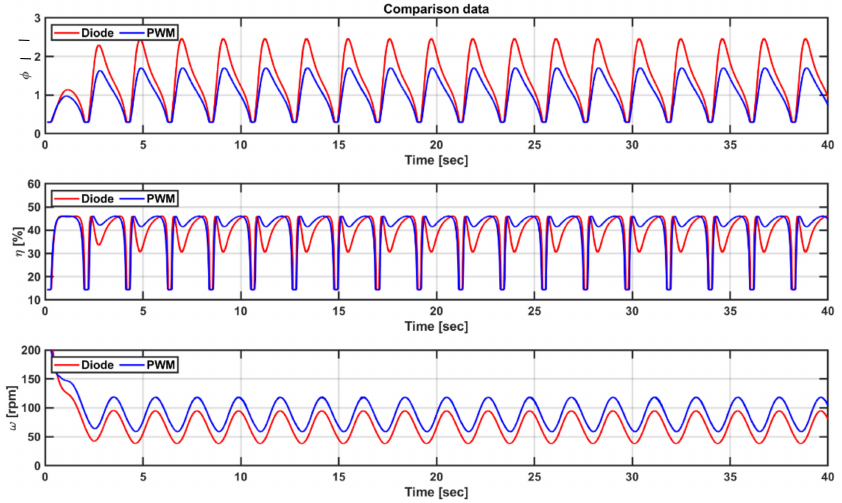
Figure 16. Comparison of turbine performance results using the PTO system in an integrated simulation at low regular wave conditions ( v t = 0~5 m / s and T = 4.25